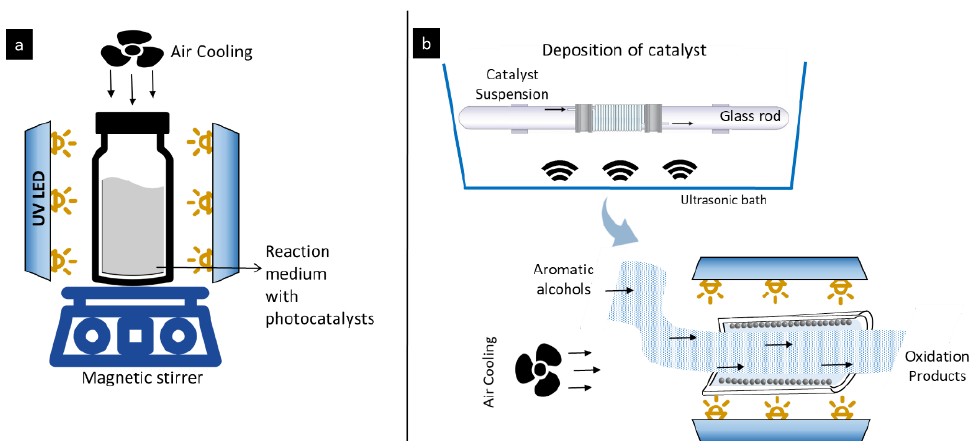
Figure 1. Experimental set up of the batch system ( a ) and microflow ( b ) photocatalytic system along with preparation of the wall-coated microreactor. with preparation of the wall-coated